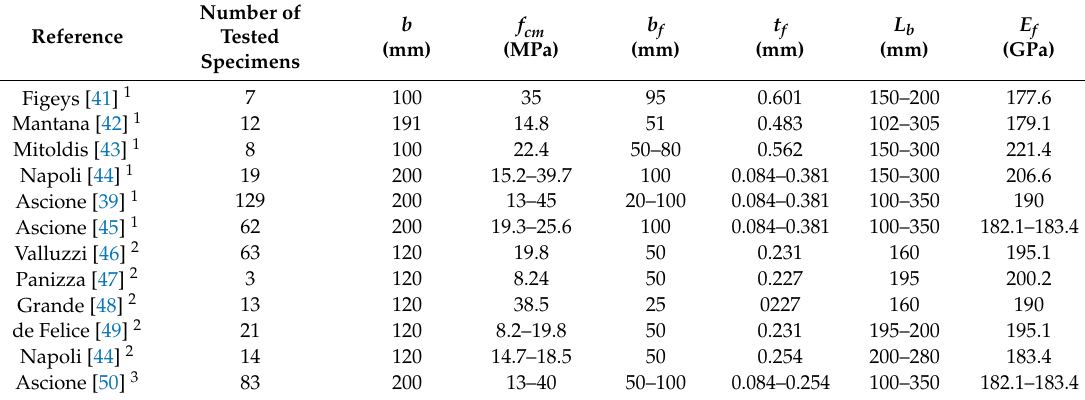
Table 3. List of geometry and material properties collected from the available experimental data and used for comparison.